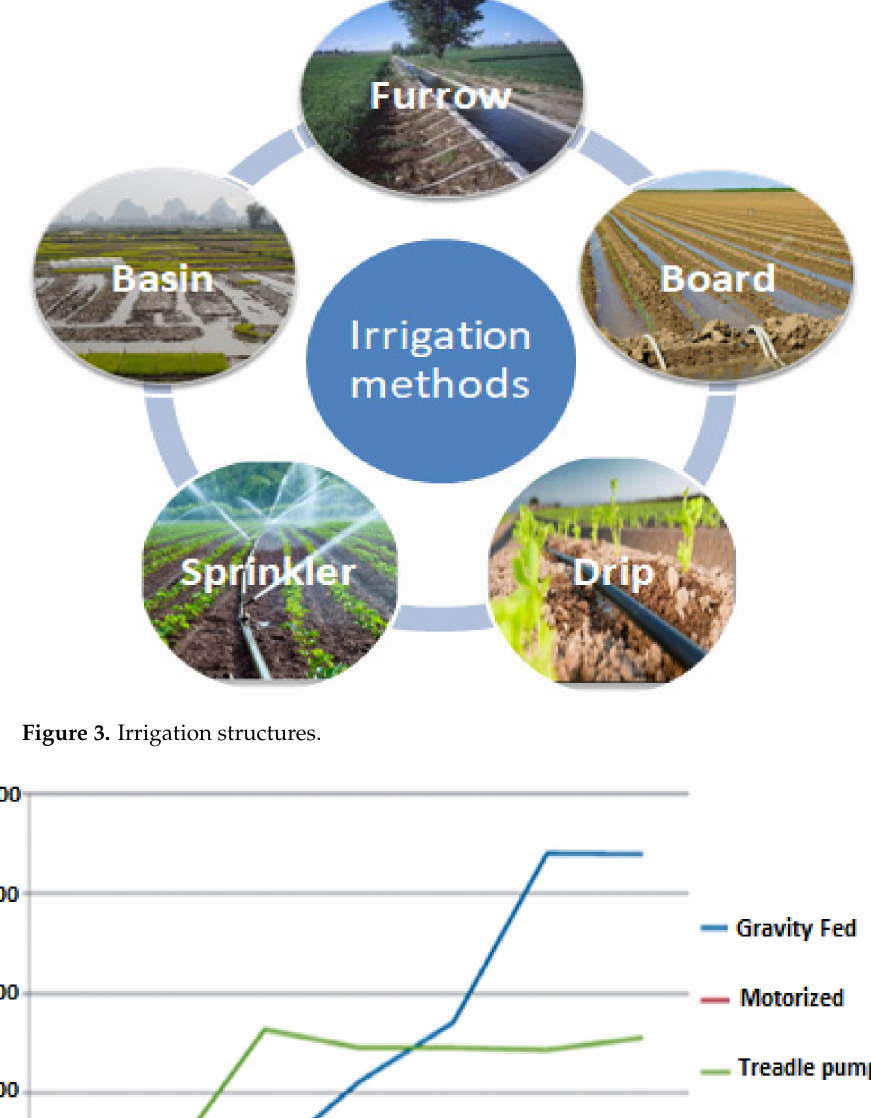
Figure 4. Trends in irrigation development by